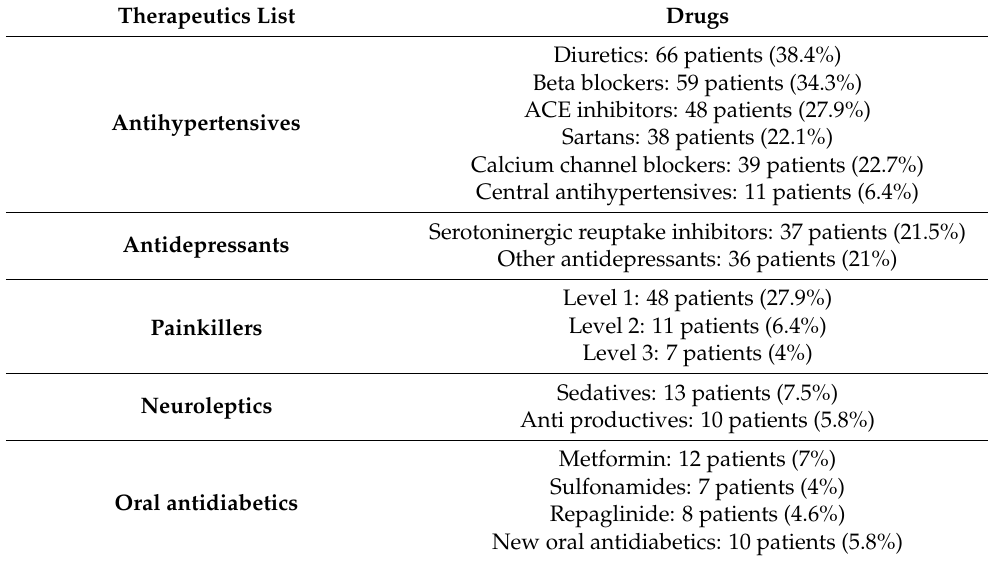
Table 2. Therapeutics list. Therapeutics